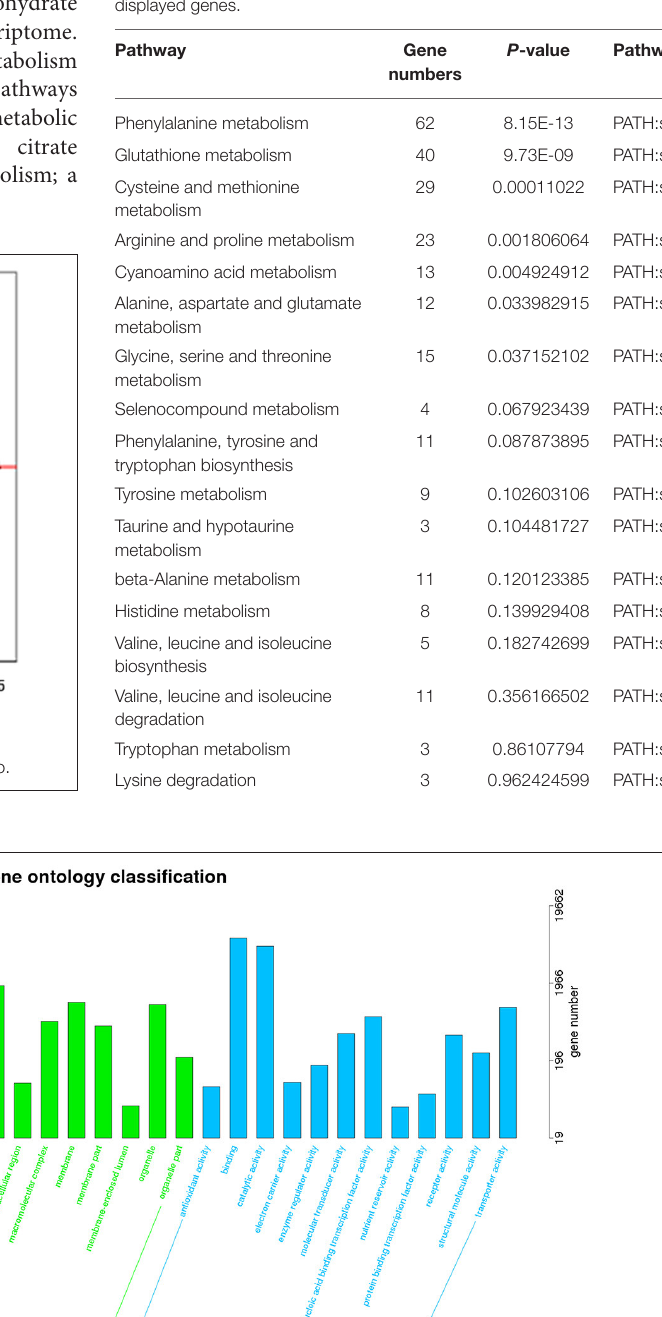
TABLE 4 | Amino acid metabolic pathway enrichment analysis of differentially displayed genes.